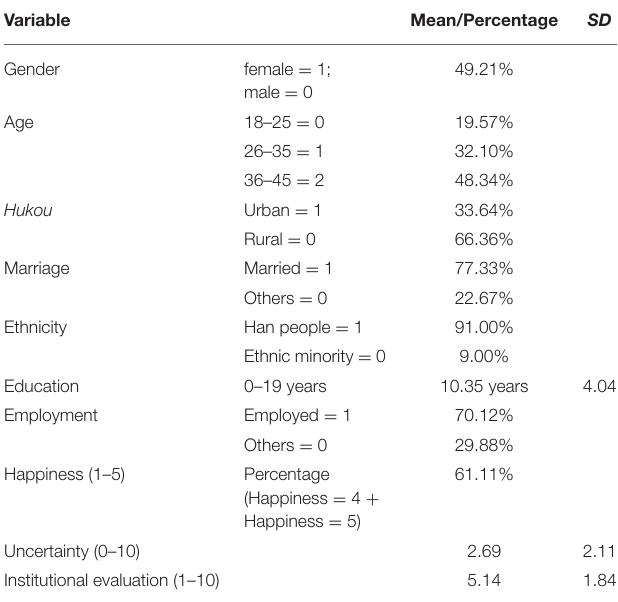
TABLE 4 | Descriptive statistics of all variables ( N = 4,605). TABLE 5 | Ordinal logistic model for